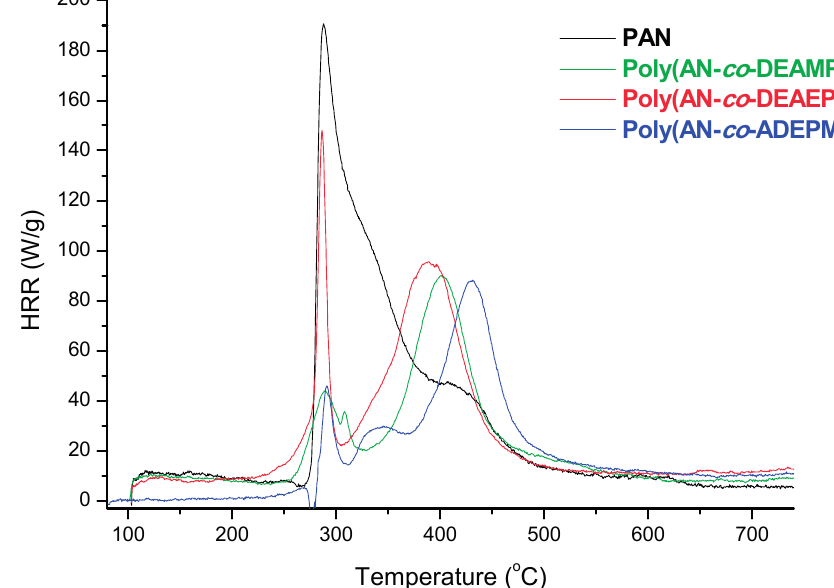
Figure 2. Plots of heat release rates versus temperature for PAN, poly(AN- co -DEAMP), poly(AN- co -DEAEP), and poly(AN- co -ADEPMAE).